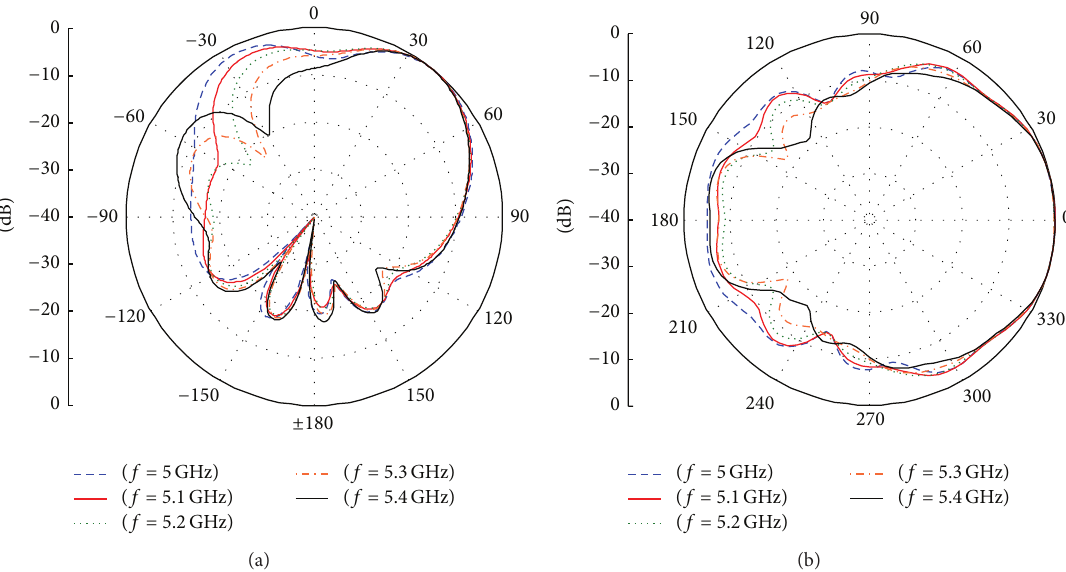
Figure 11: Elevation radiation patterns (a) in the 𝑥𝑧 plane and azimuth radiation patterns (b) in the 𝑥𝑦 plane for the 4-element Yagi array of half-wave patch antennas.